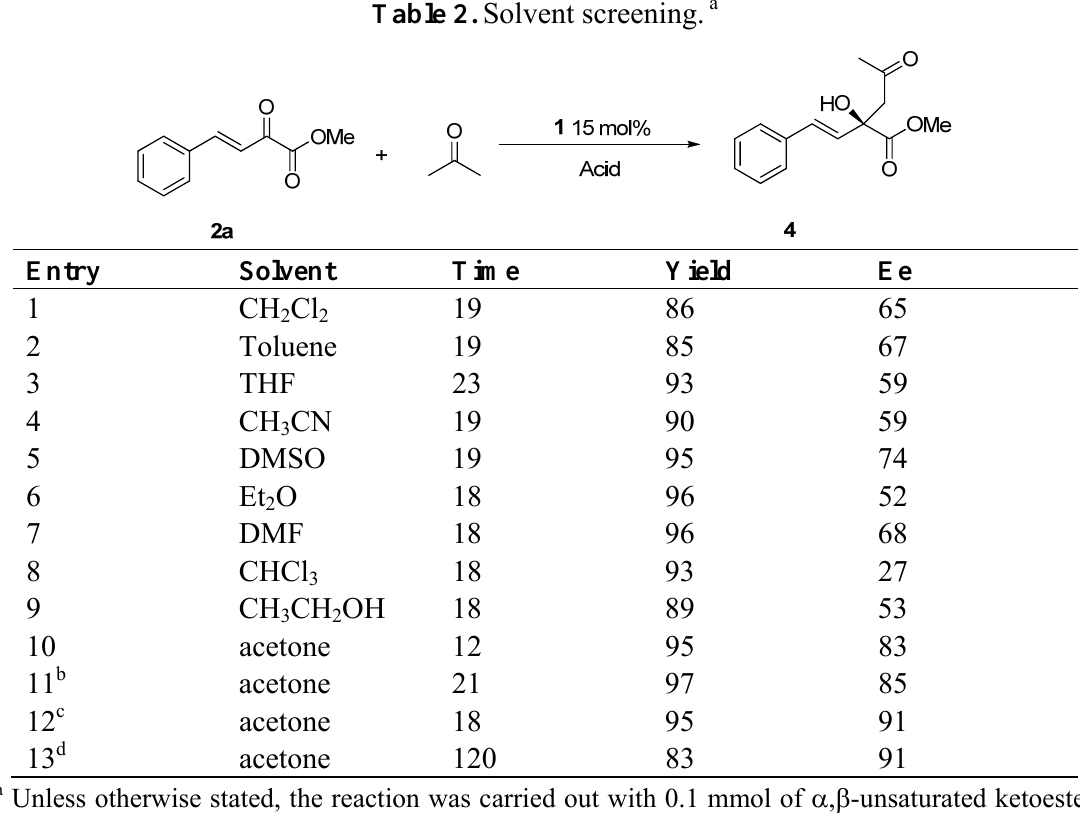
Table 2. Solvent screening.